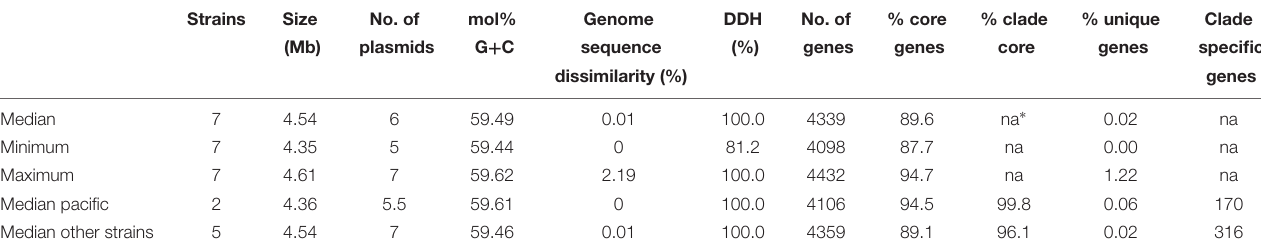
TABLE 3 | Characteristics of Phaeobacter gallaeciensis genomes. Strains